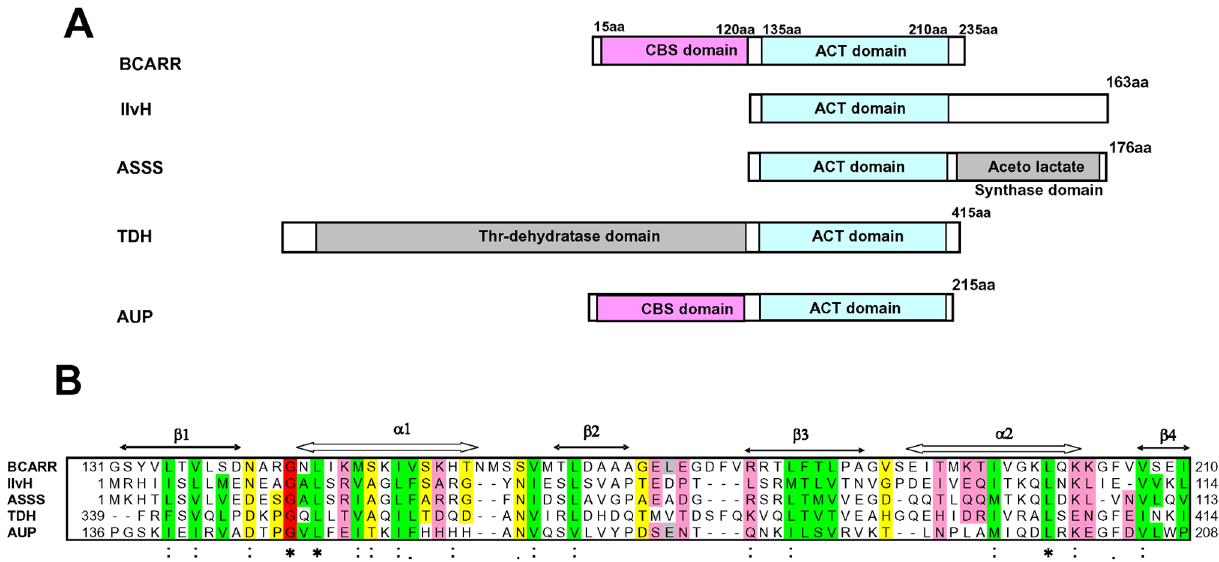
Figure 7. Homology search and sequence alignment of the ACT domain of the L.helveticus BCARR protein. Predicted schematic domain structure of the L. helveticus BCARR protein and proteins with similarity to the C-terminal region of the BCARR identified by PSI-BLAST (A). Sequence alignment of the ACT domain of the L. helveticus BCARR protein and reported ACT domain proteins (B). The sequence alignment was performed using ClustalW. Helices and beta-strands are represented by arrows and are labeled ‘‘ a ’’ and ‘‘ b ’’ respectively. The color scheme generally follows that of Grant et al. [23], and Aravind and Koonin [41] and refers to the following residue types: green, hydrophobic (ILVCAGMFYWTP); magenta, polar (HKREQDNST); gray, large (FILMWYKREQ); yellow, small (ACGSTDNVP); and red, conserved glycine. IlvH; Acetohydroxylate synthase small regulatory subunit [ Nitrosomonas europaea ] (ref|NC_004757.1|), ASSS; Acetolactate synthase small subunit [ Synechococcus sp. WH 7803] (emb|CAK24070.1|), TDH; threonine dehydratase [ Selenomonas noxia F0398] (gb|EHG23294.1|), AUP; acetoin utilization protein [ Lysinibacillus sphaericus